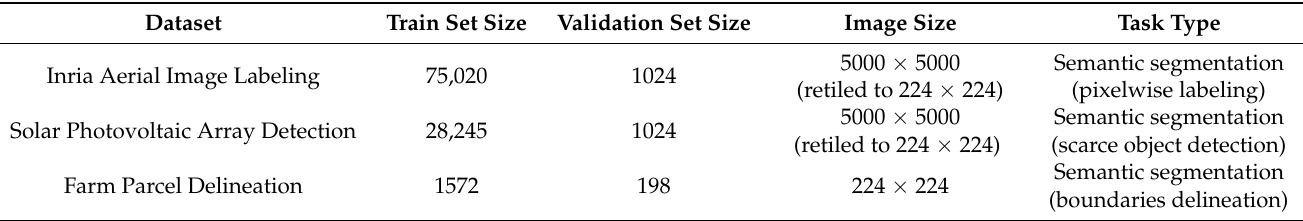
Table 2. The three semantic segmentation datasets used for our experiments. The training size varies from 1572 for the farm parcel delineation dataset to 75,020 for the Inria aerial image labeling dataset, allowing us to study the effect of training dataset size. The images either come in size 224 × 224 or as 5000 × 5000 Sentinel-2 tiles that we retile to get 224 × 224